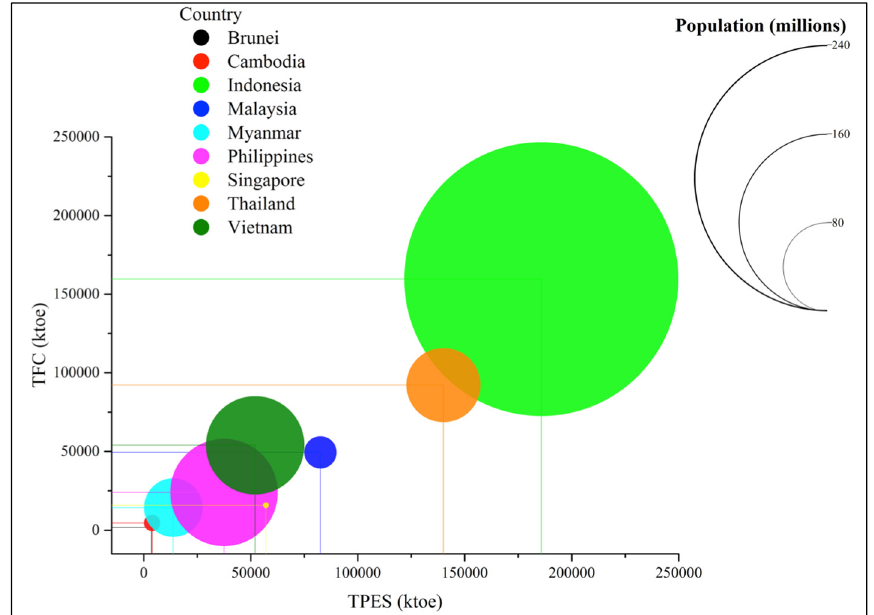
Figure 24. ASEAN energy demand, consumption, and population.